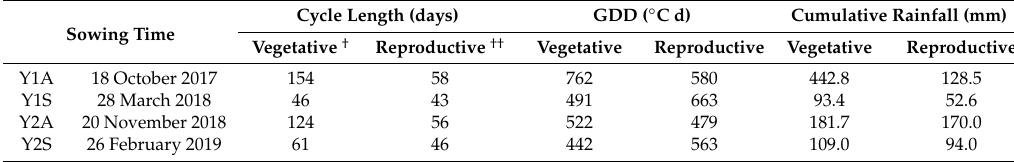
Table 2. Length (days), growing degree days (GDD) ( ◦ C d) and cumulative rainfall (mm) corresponding to vegetative and reproductive cycles of camelina in autumn (Y1A and Y2A) and spring sowing (Y1S and Y2S) in both years of cultivation (Y1 and Y2). Data are averaged over all genotypes. Cycle Length (days) GDD ( ◦ C Sowing Time